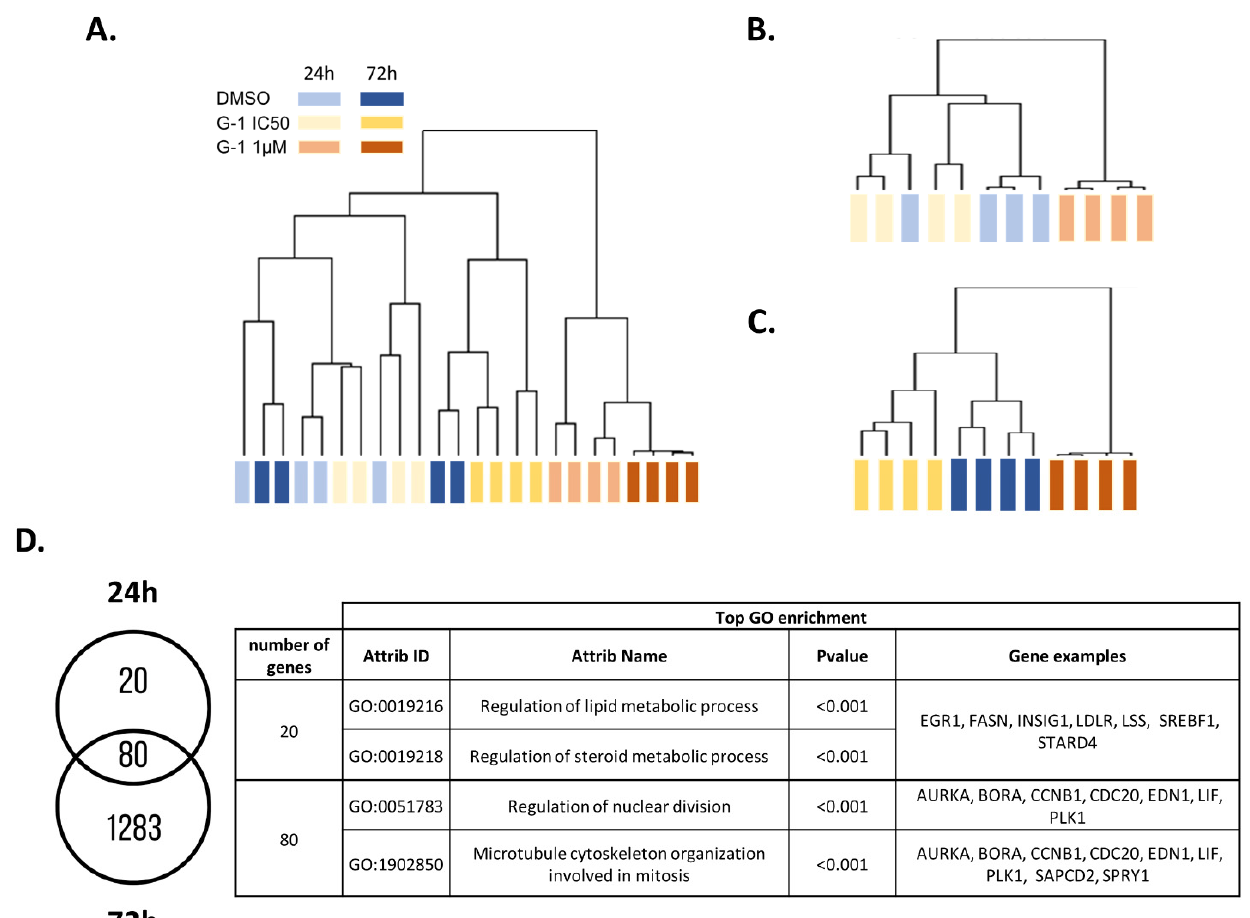
Figure 2. Transcriptomic profile of U251 cells exposed to G-1 in a dose- and time-dependent manner. ( A ) Hierarchical clustering of U251 GBM cells depending on the gene transcription between DMSO 0.01% (vehicle), G-1 IC50 (644.8 nM), and G-1 1 µM at 24 h and 72 h of treatment. ( B ) Hierarchical clustering at 24 h and ( C ) 72 h after DMSO 0.01%, G-1 IC50, and G-1 1 µM exposure. ( D ) Venn diagram of the corresponding differentially expressed genes after G-1 exposure at 24 h and 72 h. The corresponding top GO enrichments and genes associated are summarized in the